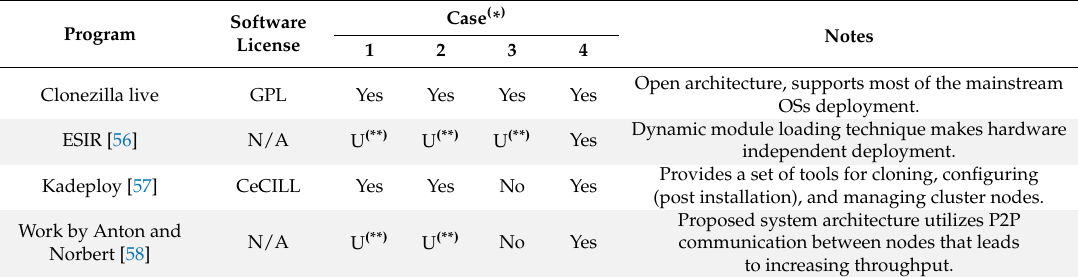
Table 7. Comparisons of bare-metal provisioning solutions that include the BT solution. CeCILL: CEA CNRS INRIA Logiciel Libre, ESIR: efficiency, scalability, independence, and reliability; GPL: General Public License, OS: operation